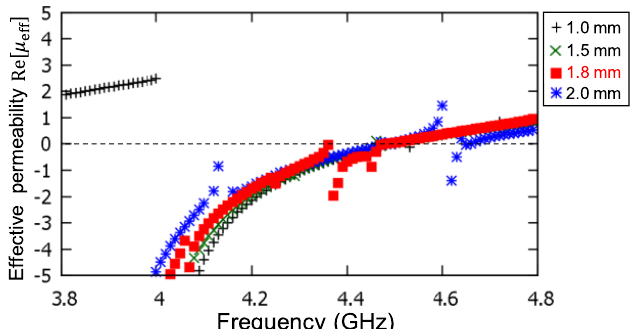
Fig. 11. Extracted real part of the effective permeability for the structure with printed meander-line patterns.